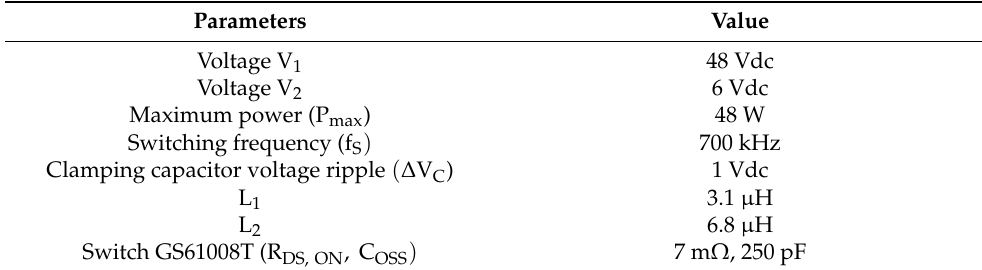
Figure 9. Waveforms of voltage V 1 , clamping capacitor voltage V c , and V 2 : ( a ) forward flow; ( b ) reverse flow. Table 1. Specification of the high-voltage-gain bidirectional DC–DC converter.